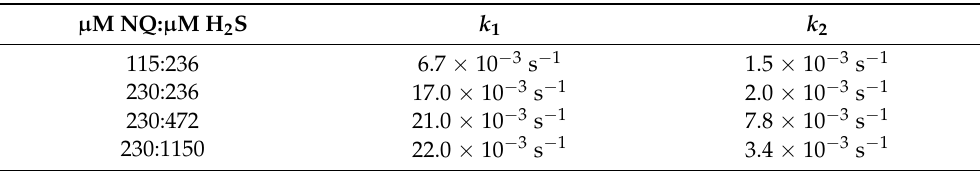
Table 1. Rate constants A → B ( k 1 ) and B → C ( k 2 ) for deconvoluted UV-Vis absorbance spectra of the H 2 S reaction with 1.4 naphthoquinone